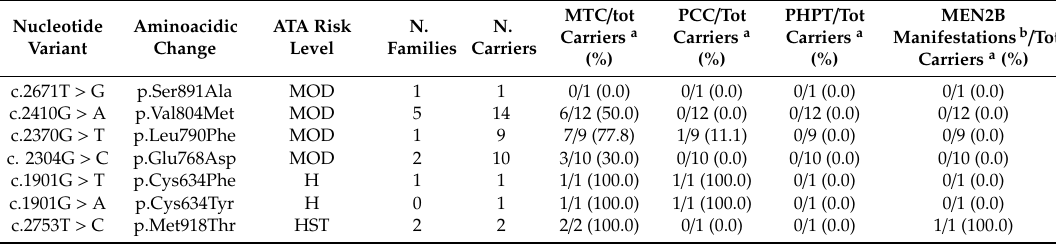
Table 1. RET classified variants detected in the population under